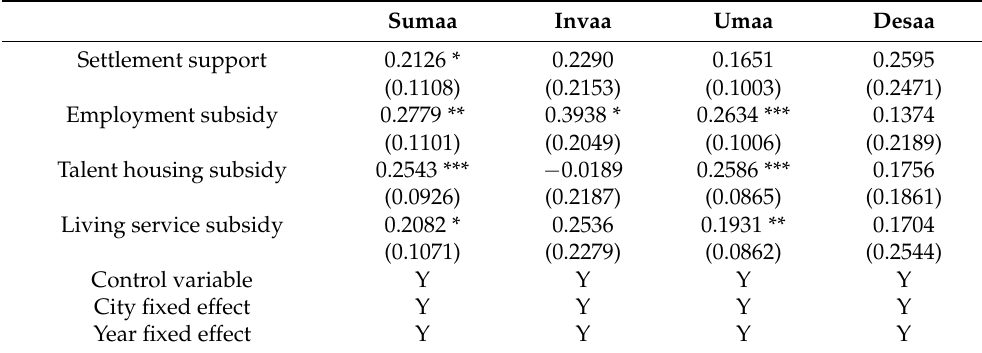
Table 4. Regression results of the influence of talent policy subsidy mode on urban